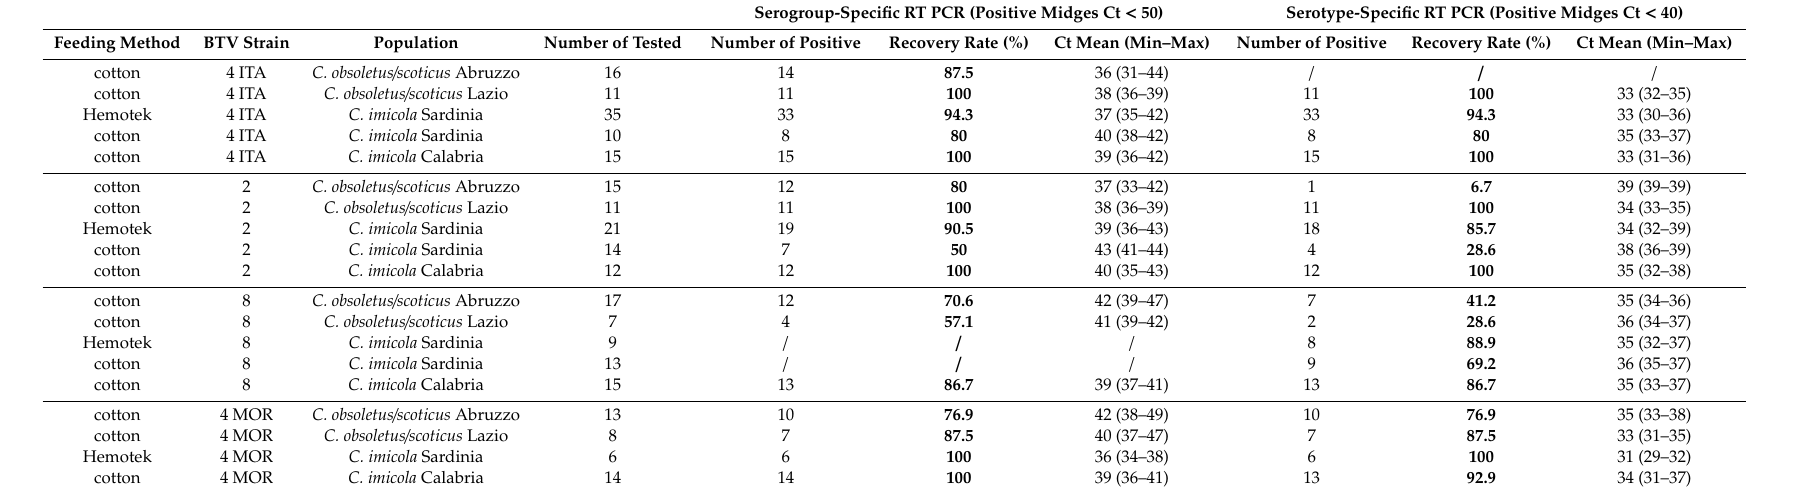
Table 3. Virus detection in Culicoides tested immediately after feeding on BTV-infected blood at 0 days post-infection.